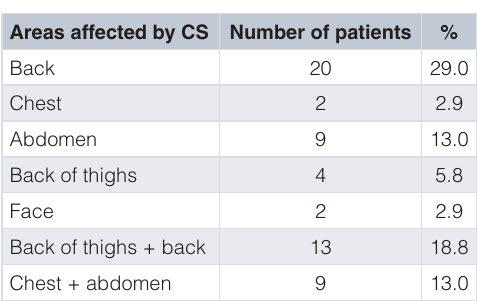
Table 5. Distribution of areas affected by compensatory sweating (CS) post-endoscopic thoracic sympathectomy.